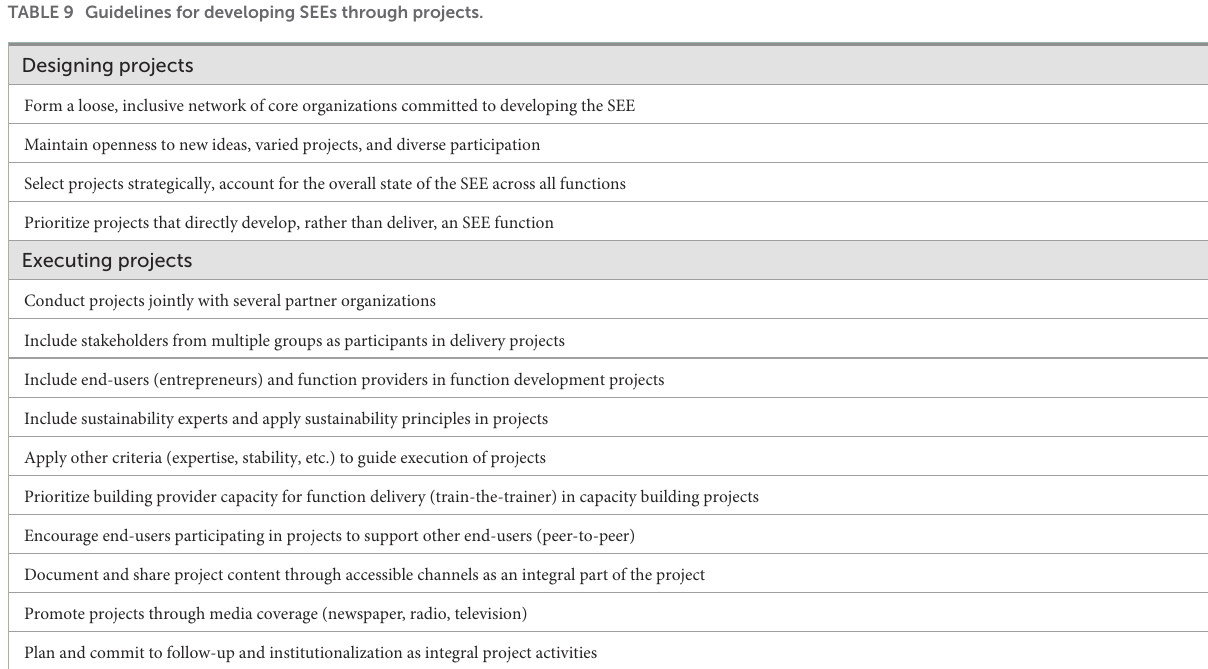
TABLE 9 Guidelines for developing SEEs through